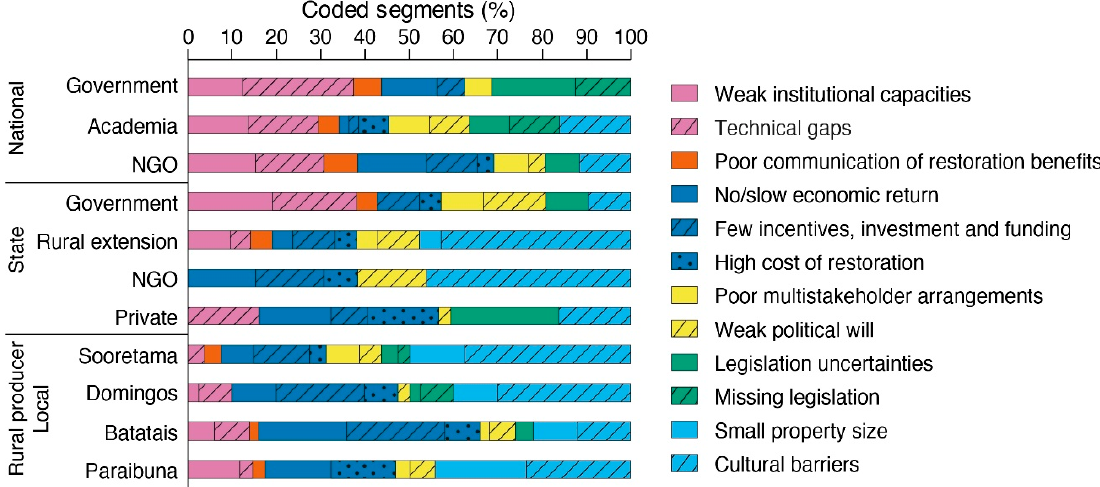
Figure 4. Code intersection on barriers for upscaling forest restoration as perceived by the different actors at different scales. Colour codes correspond to themes and patterns to subthemes from Table 4: pink = capacity issues, red = communication, dark blue = financial, yellow = governance, light blue = social.